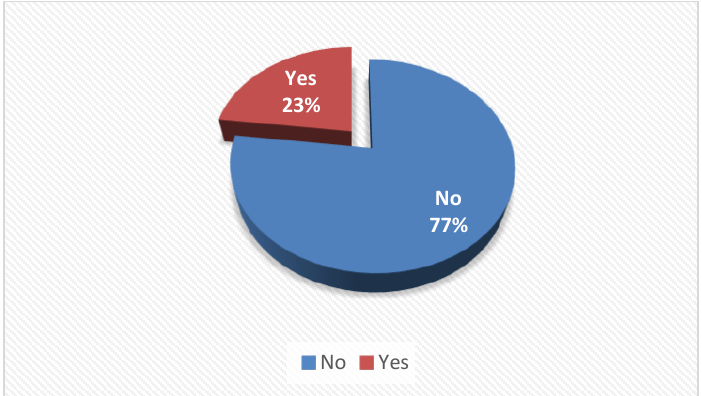
Figure 3: Participation in the IDP process; Source :